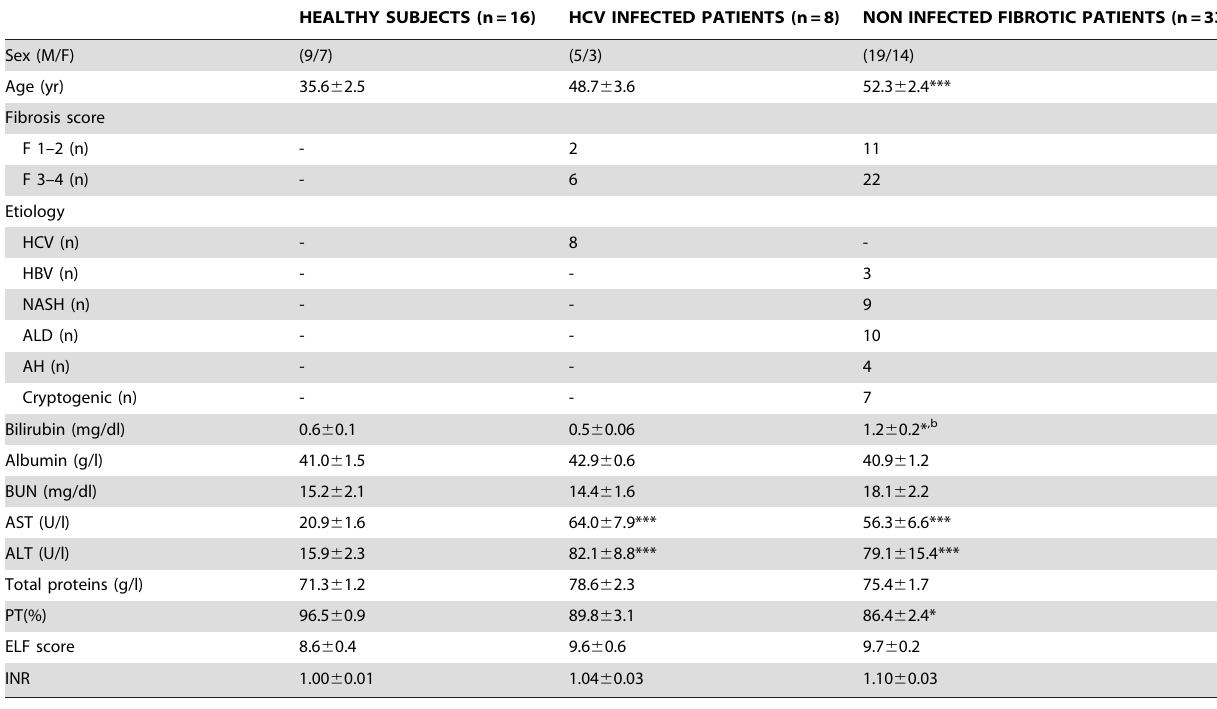
Table 3. Baseline characteristics of healthy subjects and HCV-infected and non-infected fibrotic patients.